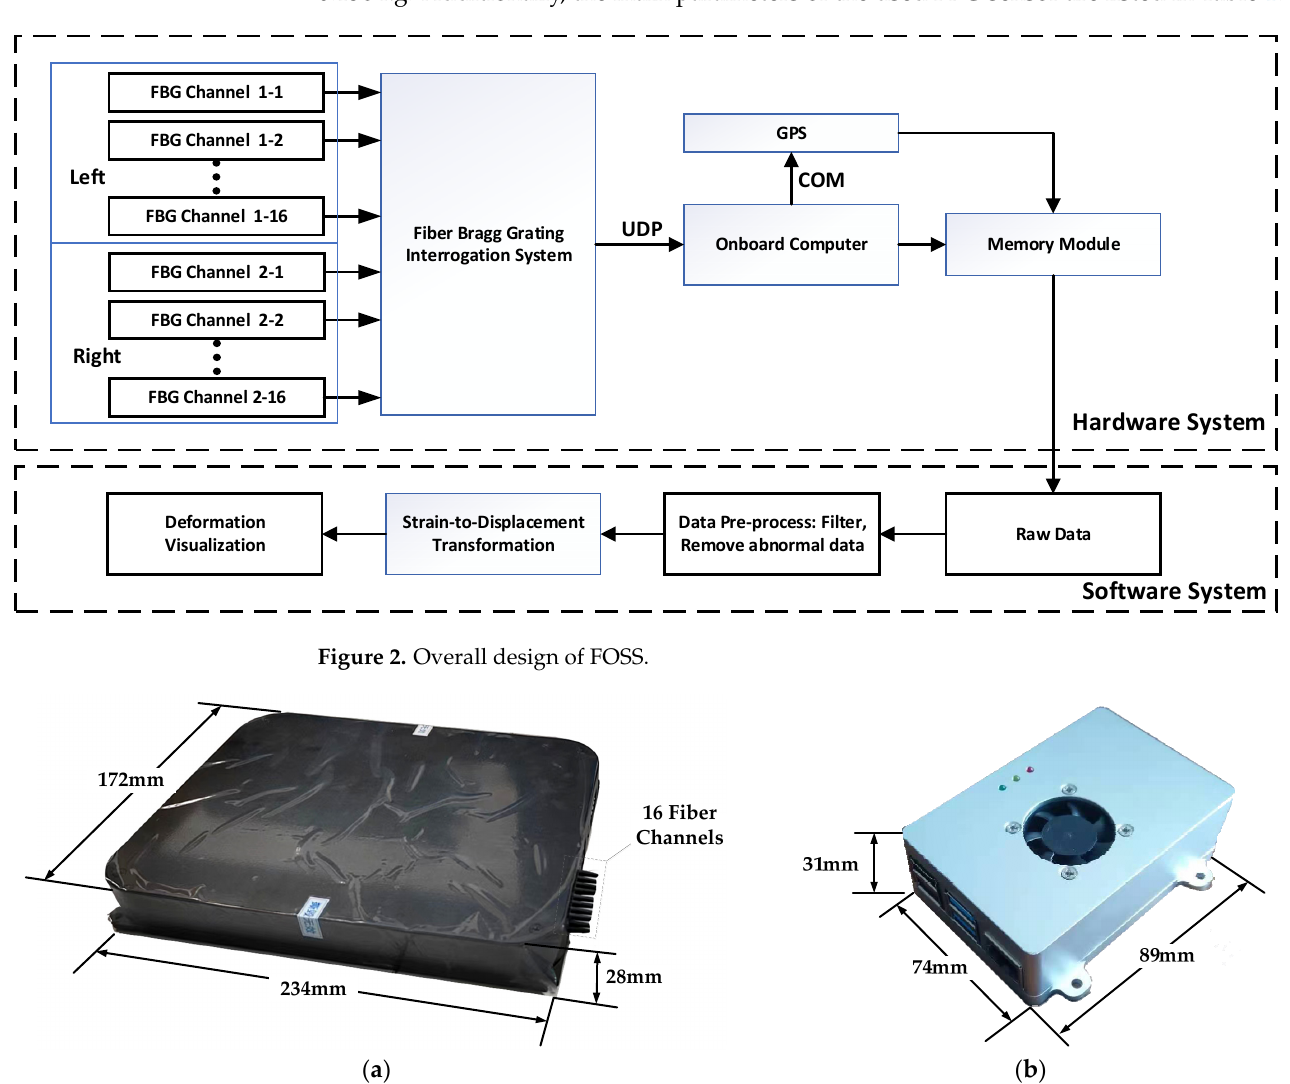
Figure 3. ( a ) FBG Interrogation System; ( b ) onboard computer. Table 1. The main parameters of FBG sensor.